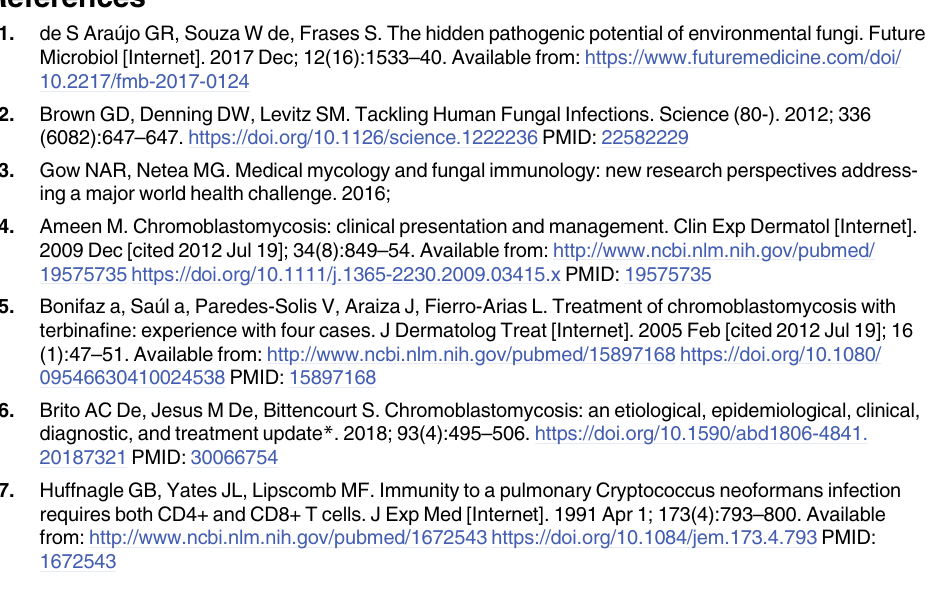
S7 Fig. F. pedrosoi fungal forms are recognized by dectin-2 and dectin-1. Interaction test between fungal forms with reporter cells expressing dectin-1 ( B ), dectin-2 ( D ), dectin-3 ( E ) and mincle ( F ) and carrying NFAT-lacZ construct was evaluated. Cells not expressing CRL ( A ) or expressing only FcR ( C ) were used as controls. � P < 0.05 and ��� P < 0.001.